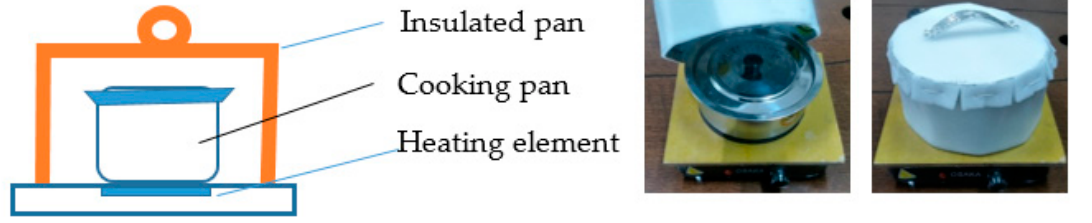
Figure 3. Schematic diagram and pictures of insulated pan covers for the cooking pans.